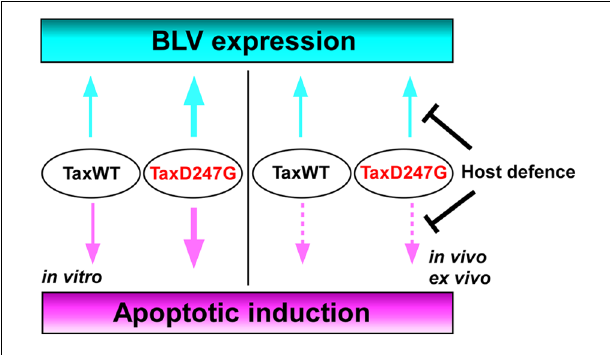
FIGURE 4 | Proposed mechanism for the regulation of BLV expression and apoptosis induction inTaxD247G-encoded BLV-infected